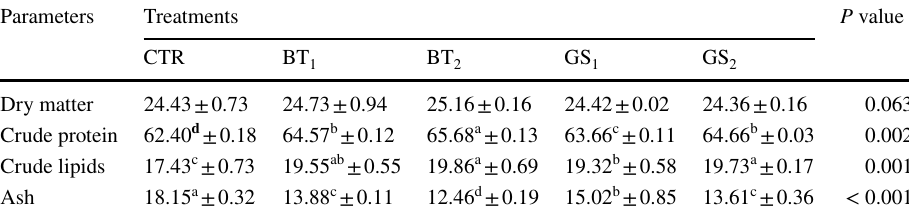
CTR, control fish group reared in clean